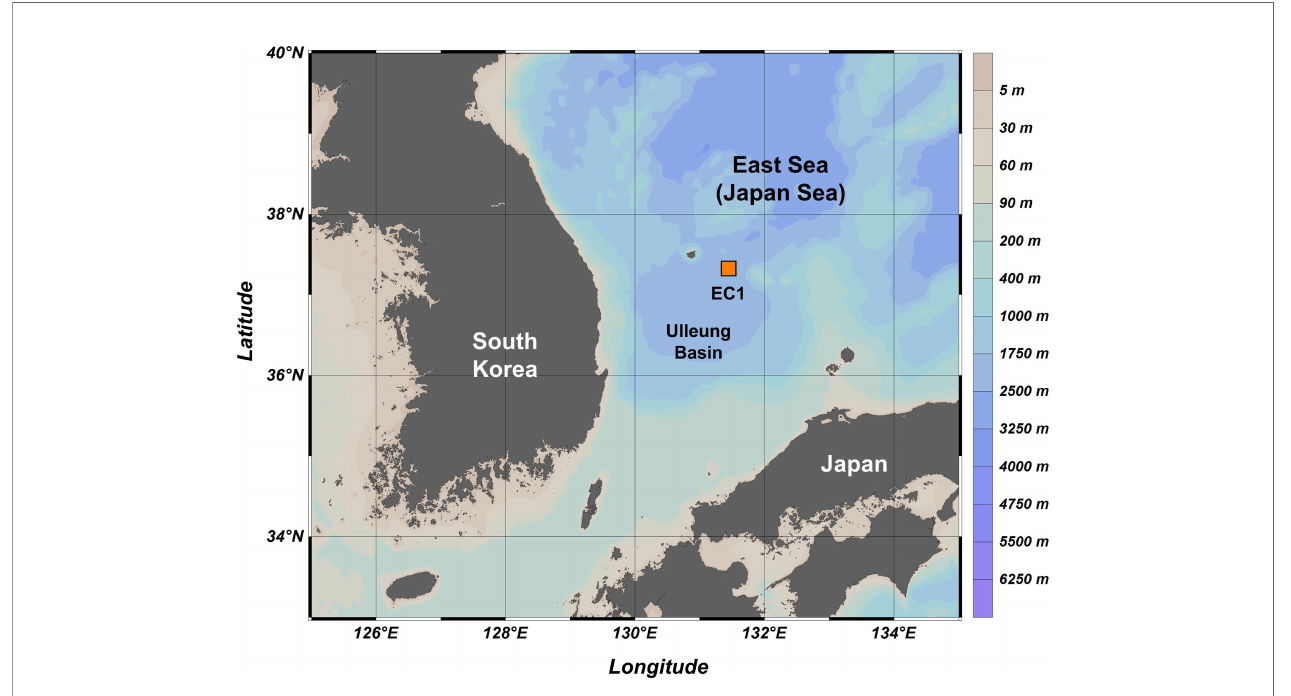
FIGURE 1 | Sampling site of this